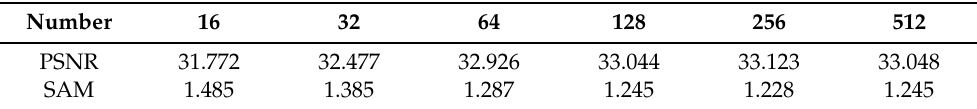
Table 1. Peak signal-to-noise ratio (PSNR) and spectral angle mapper (SAM) of SSRN with different numbers of convolutional kernels on the Washington DC Mall (WDCM) database.